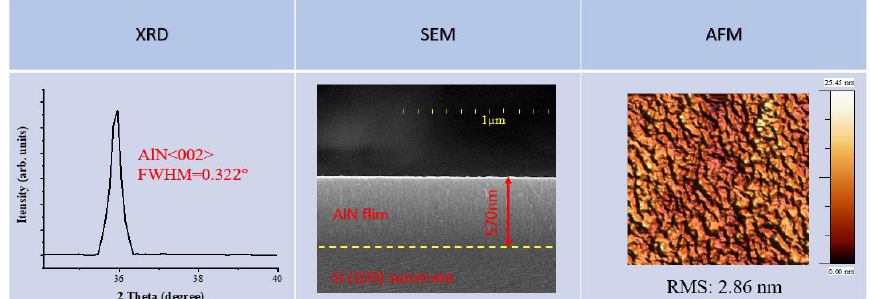
Figure 3. Typical thin film quality measurements by XRD, SEM and AFM for sample S8.